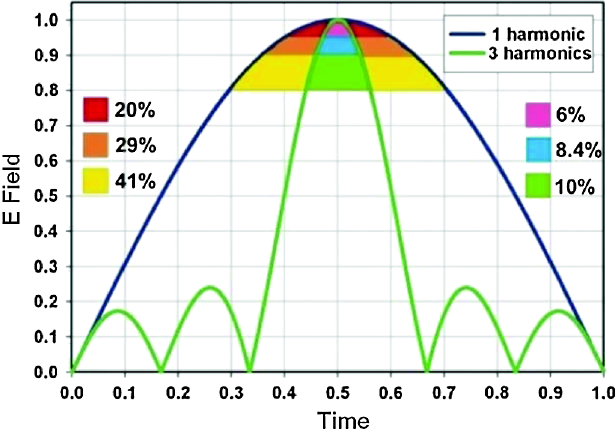
FIG. 5. (Color) Time dependence of fields in a square box cavity excited in a single mode during half of a fundamental mode period, as compared with the same cavity excited in three harmonic modes. A dramatic reduction in exposure time to strong fields for the latter case is evident. Reduction is doubled for a full cycle (cf. Fig. 2).